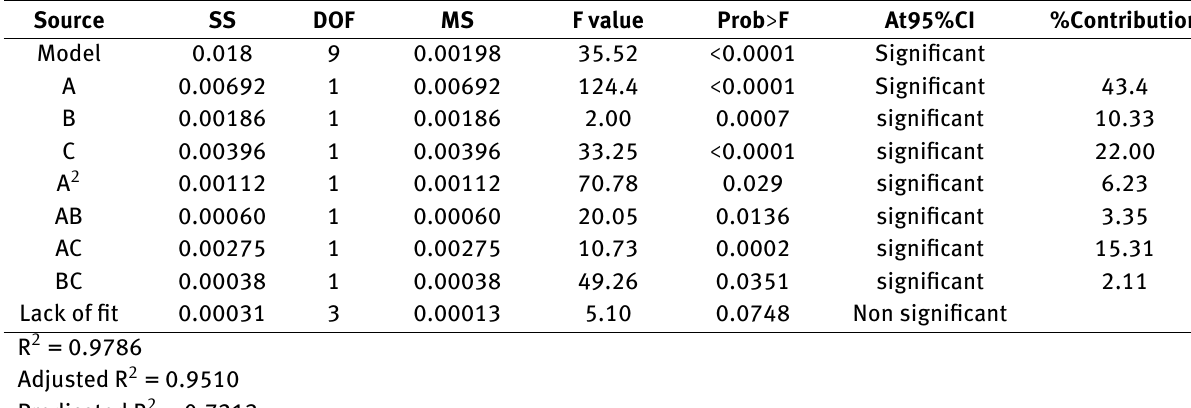
Table 5: The ANOVA for response surface quadratic model for